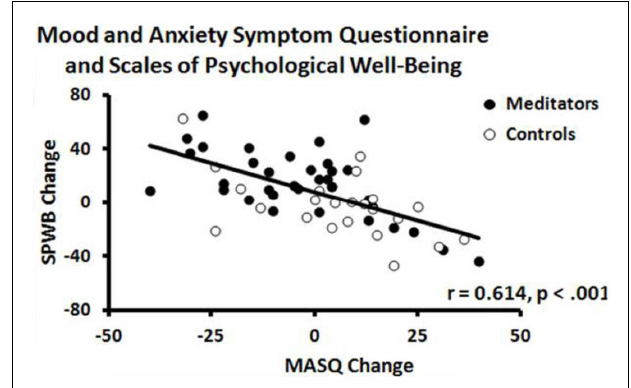
FIGURE 5 | Scatterplot of correlation between changes mood and anxiety and changes in psychological well-being scores in meditators (black circle) and controls (open